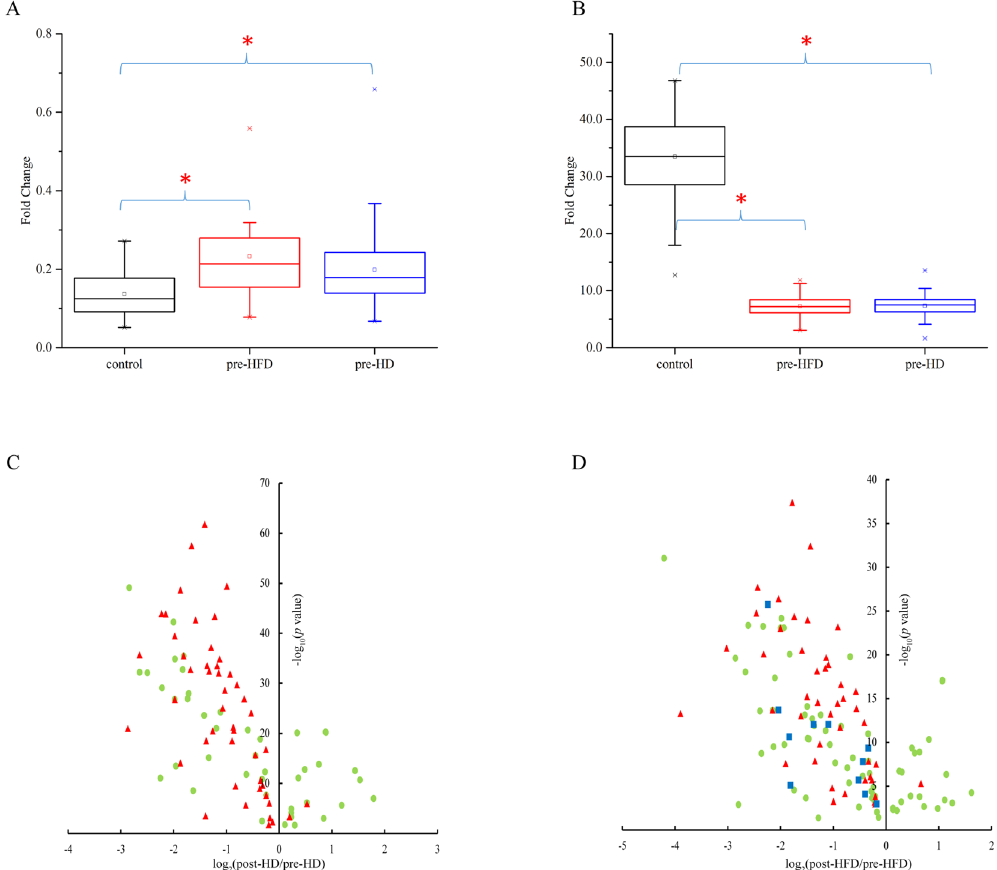
Figure 4. Significant changes in metabolites. ( A ) Box plot of Glu/Gln in control, pre-HFD and pre-HD groups. ( B ) Box plot of Trp/Kyn in control, pre-HFD and pre-HD groups. ( C ) Volcano plot of significantly altered metabolites ( p < 0.05) in HD treatment. ( D ) Volcano plot of significantly altered metabolites ( p < 0.05) in HFD treatment. Red triangle indicates uremic retention solutes and blue box shows additionally reduced uremic retention solutes in HFD